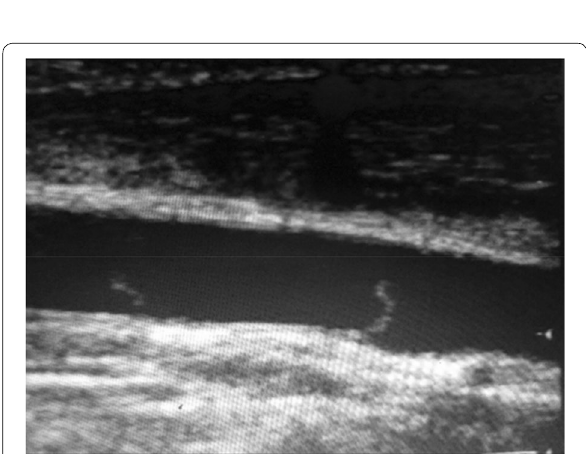
Fig. 10 Post traumatic carotid artery intimal flap. B mode. Echogenic flap into the